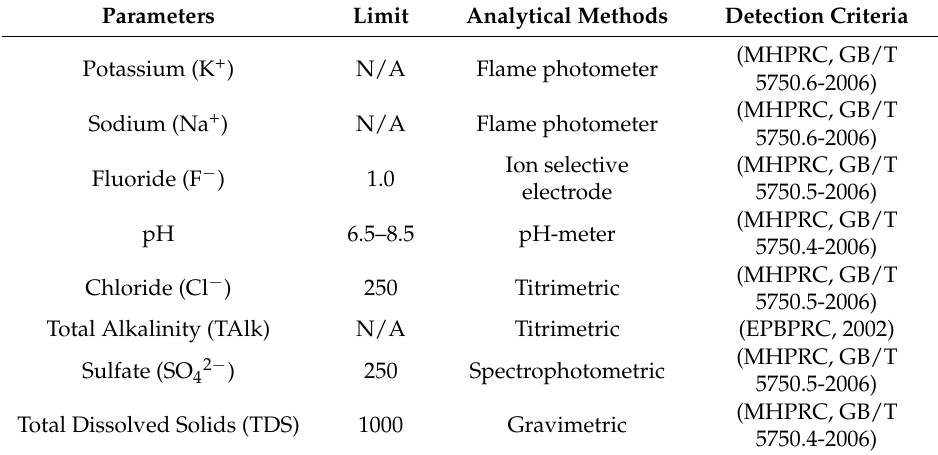
Figure 1. The drinking water sources in Yancheng City.